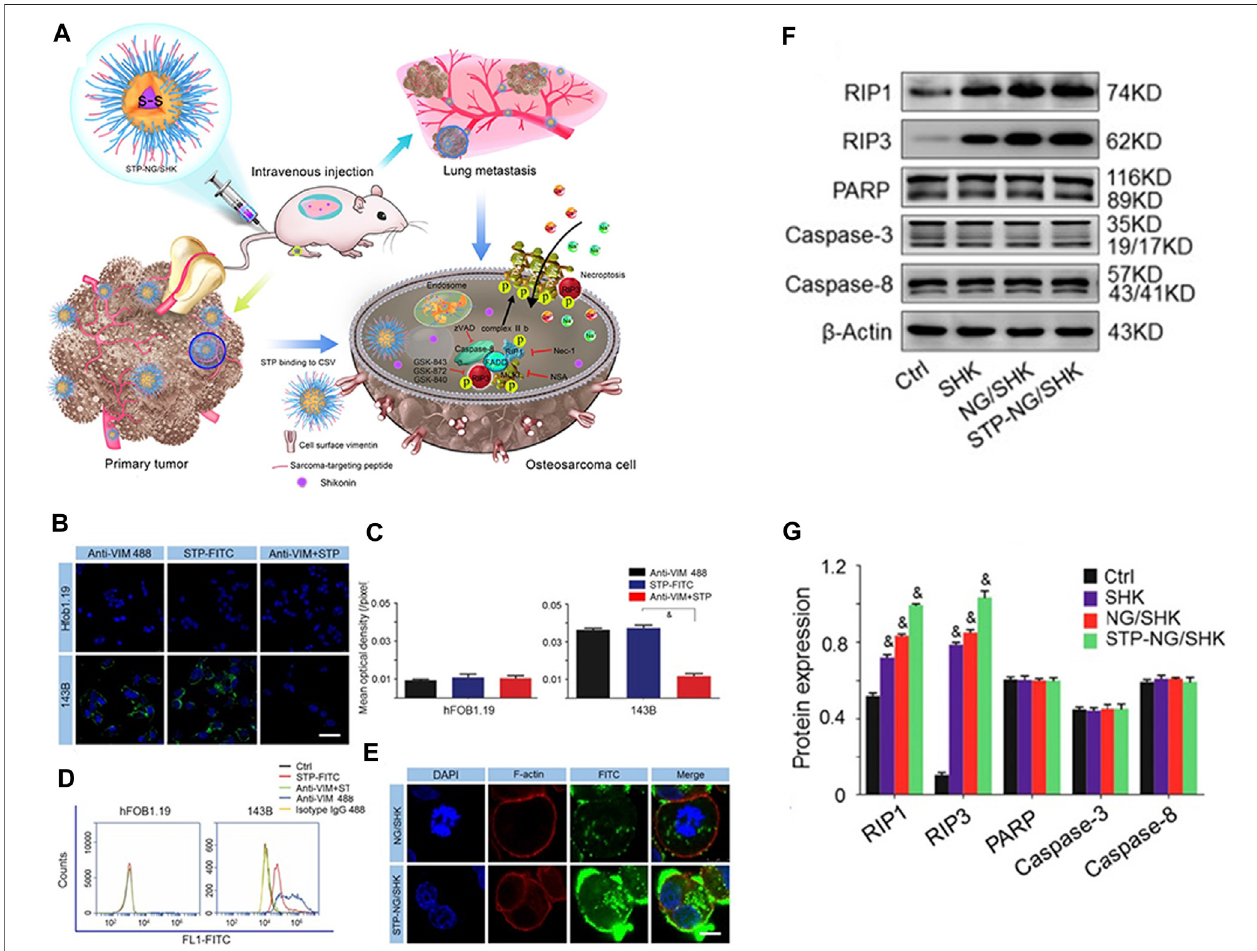
FIGURE5| Schematicdiagramofthenanogelsystemandcellexperiments(LiS.etal.,2018). (A) SchematicdiagramoftheroleofSTP-NG/SHKintumorandlung metastasis. (B) CLSMcellsurfacestaininganalysisofcellsurfacevimentin. (C) Semi-quantitativeanalysisofFigure B. (D) ImmunologicevaluationofSTPbindingtocells with fl ow cytometry. (E) Cell uptake of NG/SHK-FITC and STP-NG/SHK-FITC. Western blot (F) and semi-quantitative analysis (G) of the cells.